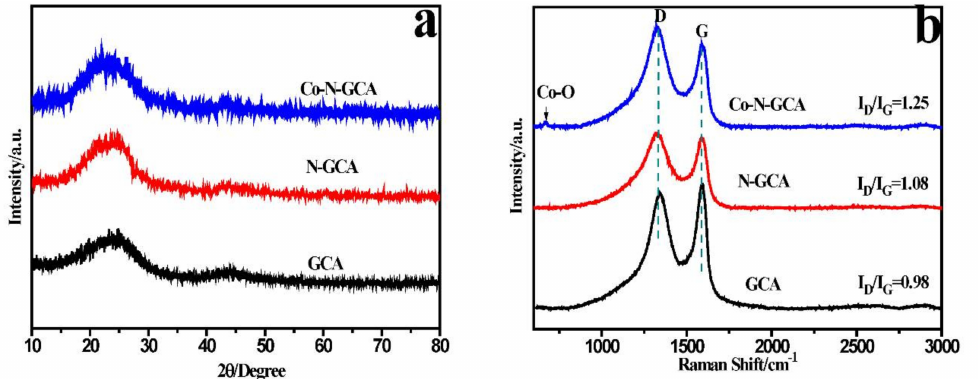
Figure 4. XRD patterns ( a ) and Raman spectra ( b ) of Co-N-GCA, N-GCA, and